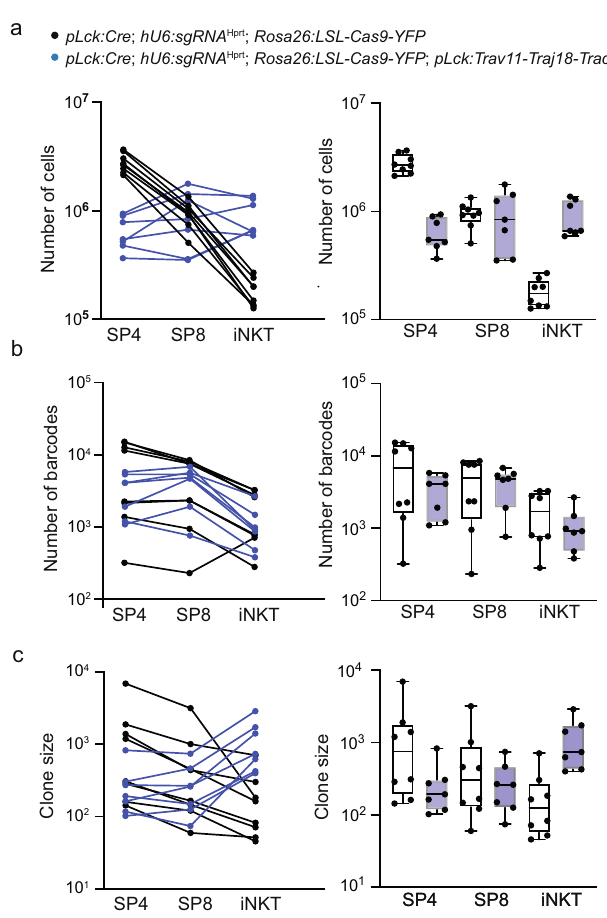
Fig. 5 Altered thymocyte population structure in pLck:Trav11-Traj18-Trac transgenic mice. a Absolute cell numbers of thymocyte populations in mice of the indicated genotypes; lines connect data for individual mice to indicate stability of differentiation trajectories (left panel). The right panel is a summary presentation of data. b Absolute barcode numbers of thymocyte populations in mice of the indicated genotypes to indicate stability of differentiation trajectories irrespective of barcoding ef fi ciency (left panel). The right panel is a summary presentation of data. c Clone sizes of thymocyte populations in mice of the indicated genotypes (left panel). The right panel is a summary presentation of data. In this experiment, mouse cohorts of approximately